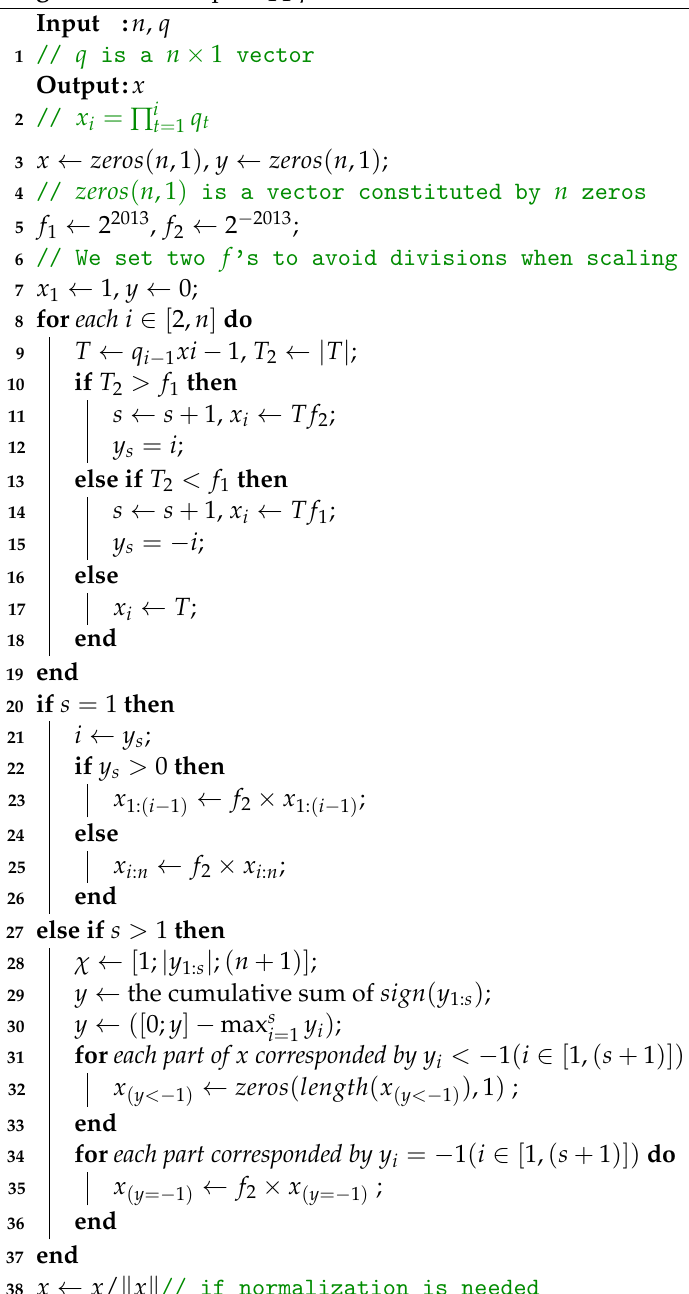
Algorithm 6: Compute ∏ q without overflow and